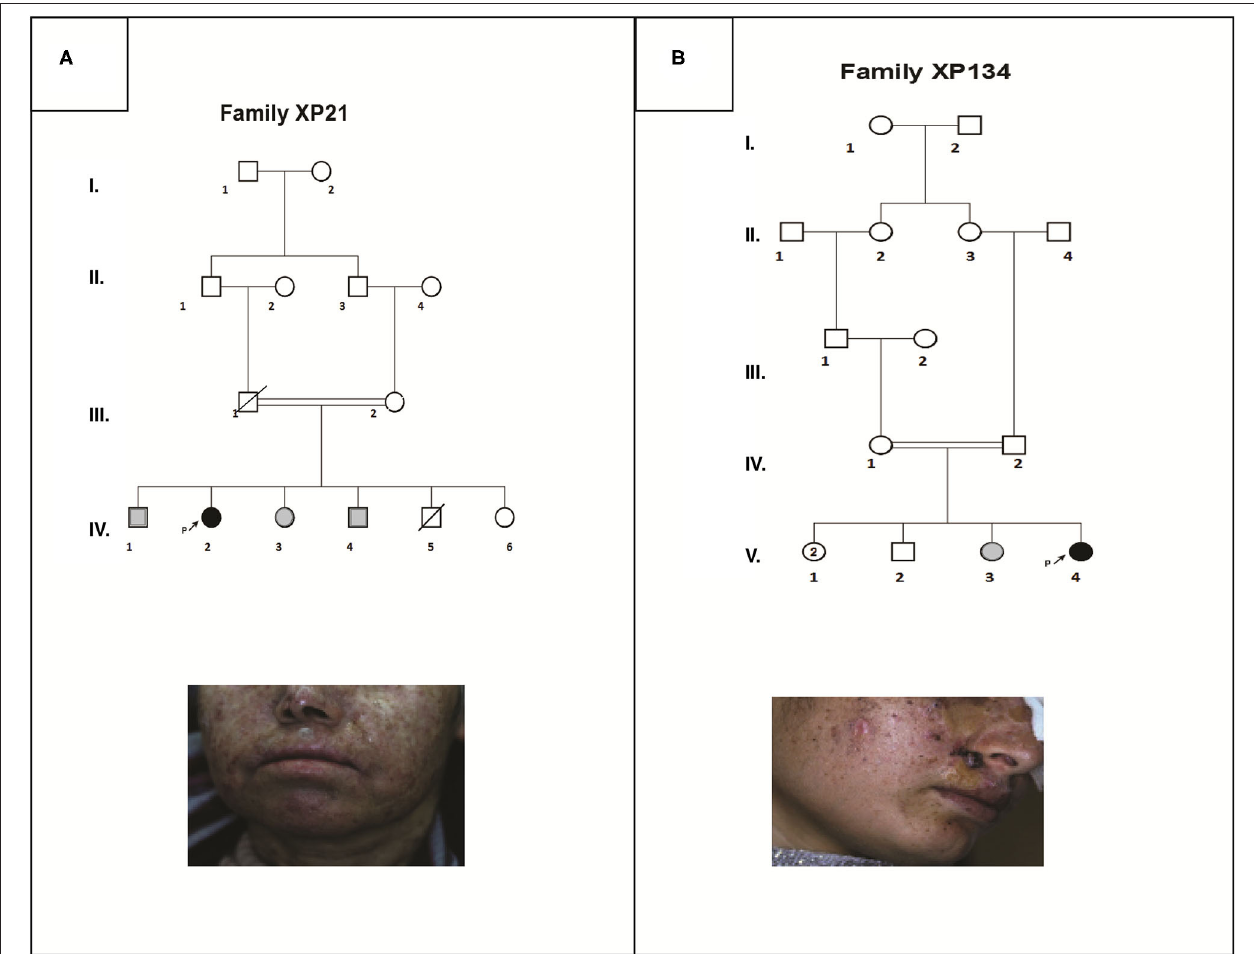
FIGURE 1 | Pedigrees and clinical images describing two XP affected family members (XP21 and XP134) (A,B) . Filled symbols represent affected individuals, open symbols represent unaffected individuals, gray symbols are for suspected individuals, the studied pro-band is indicated with an arrow.